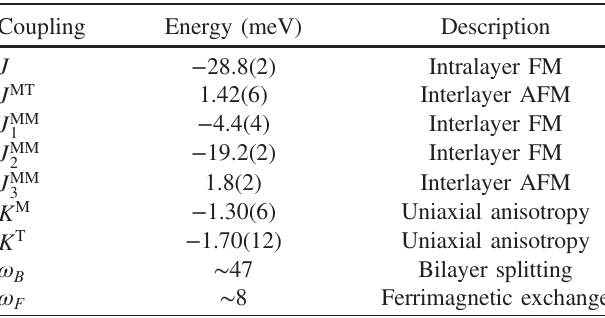
TABLE I. Heisenberg parameters for TbMn 6 Sn 6 as obtained from fits to the neutron